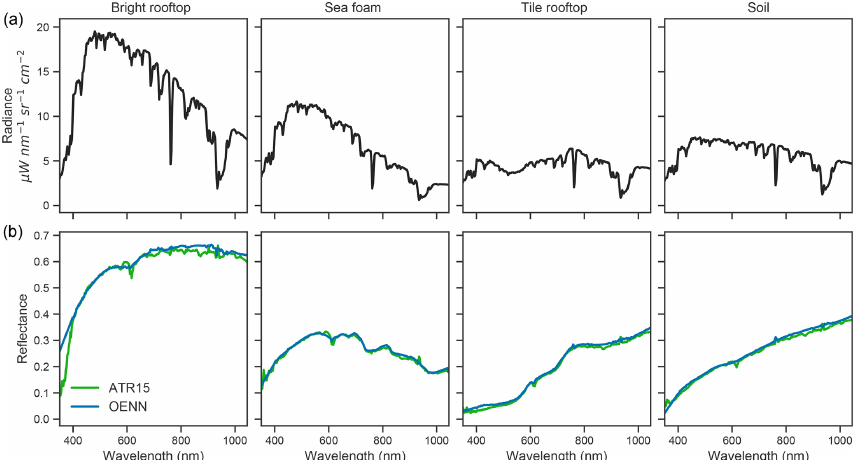
Figure 8. Selected radiance spectra (a) and corresponding surface reflectance retrievals (b) using the ATREM-based atmospheric correction approach of Thompson et al. (2015) (ATR15, green spectra) versus optimal estimation equipped with our neural network RTM emulator as the forward model (OENN, blue